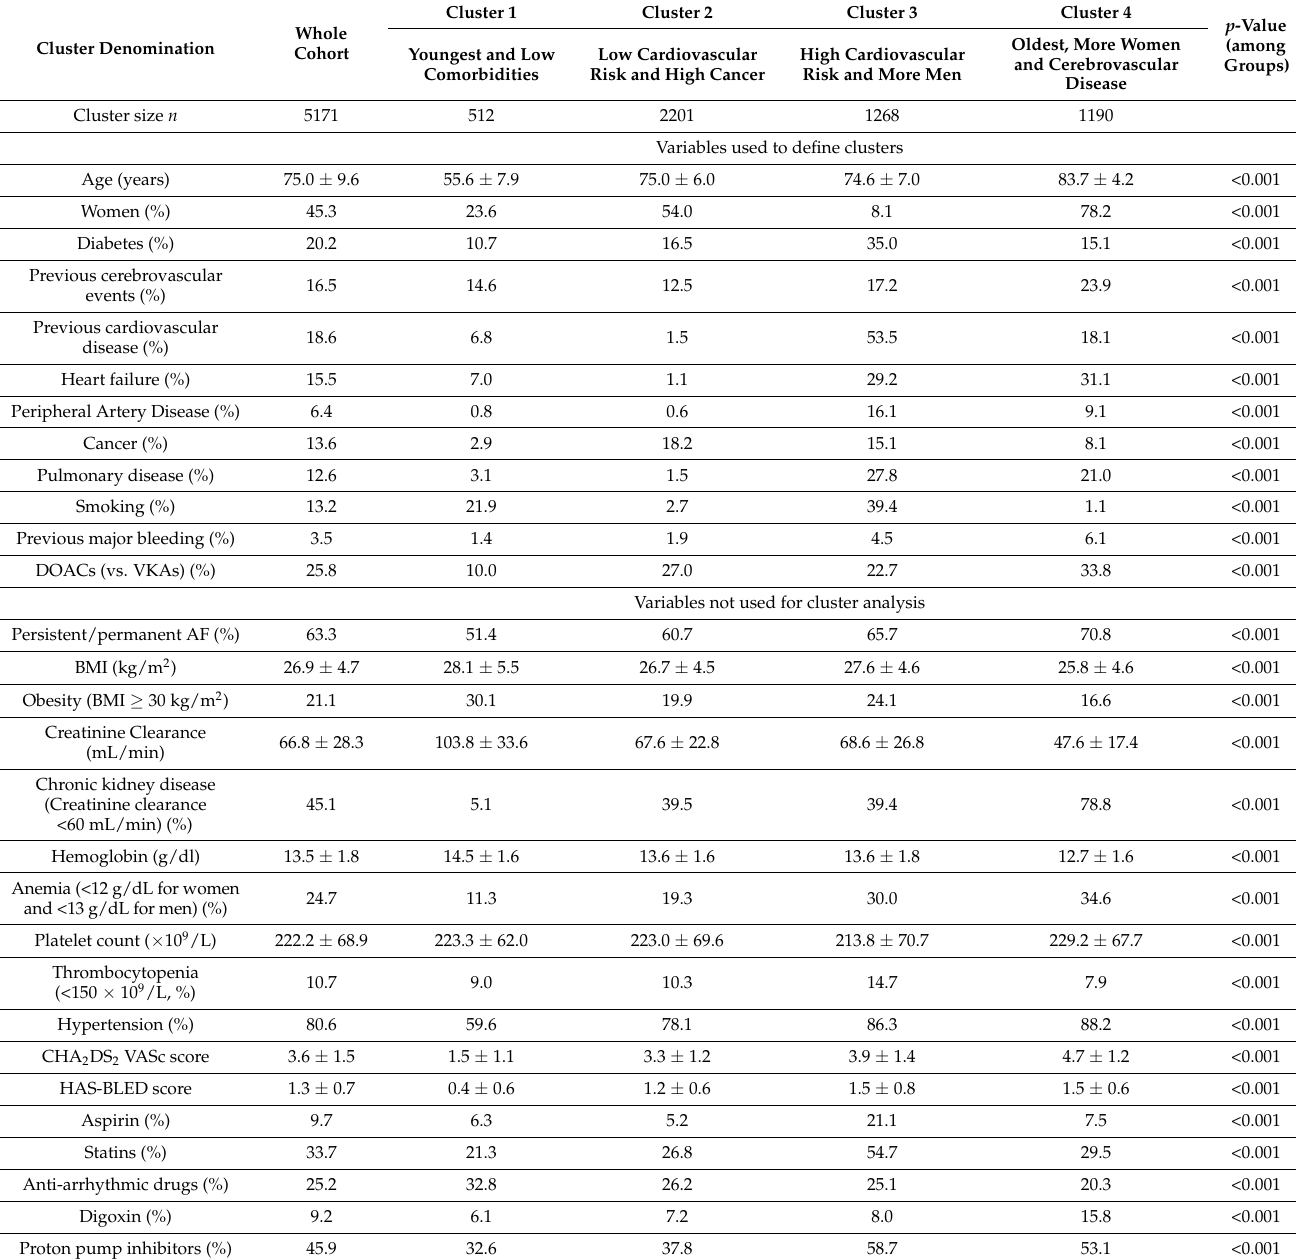
Table 1. Clinical and biochemical characteristics of patients according to each